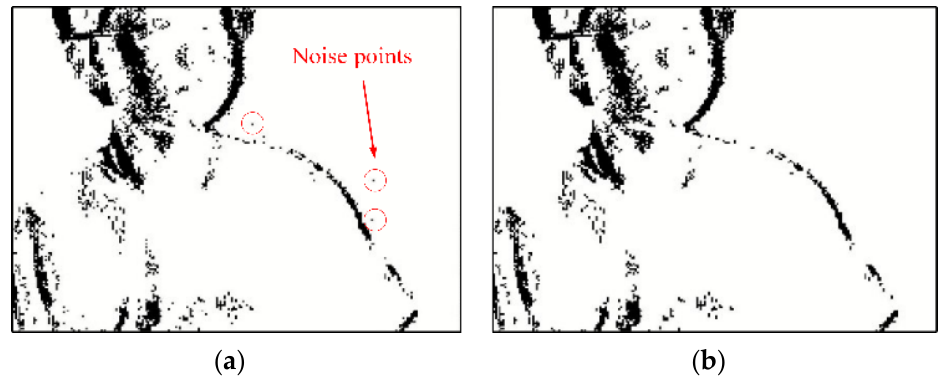
Figure 6. Results of nearest neighbor filter in a dynamic environment. ( a ) Before filtering, ( b ) After filtering.